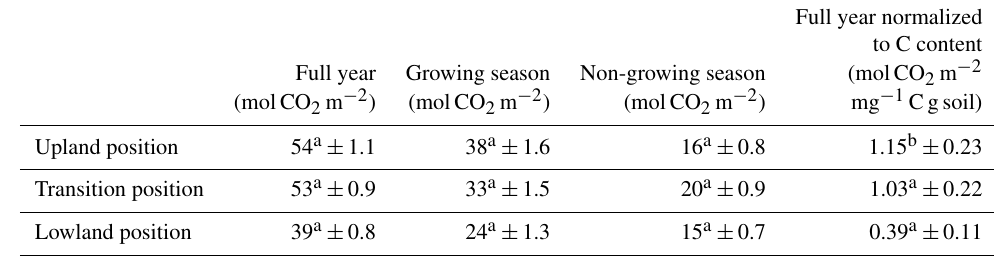
Table 1. Average cumulative CO 2 emissions ( n = 6 ± standard error) for each landscape position across upland–lowland transects.